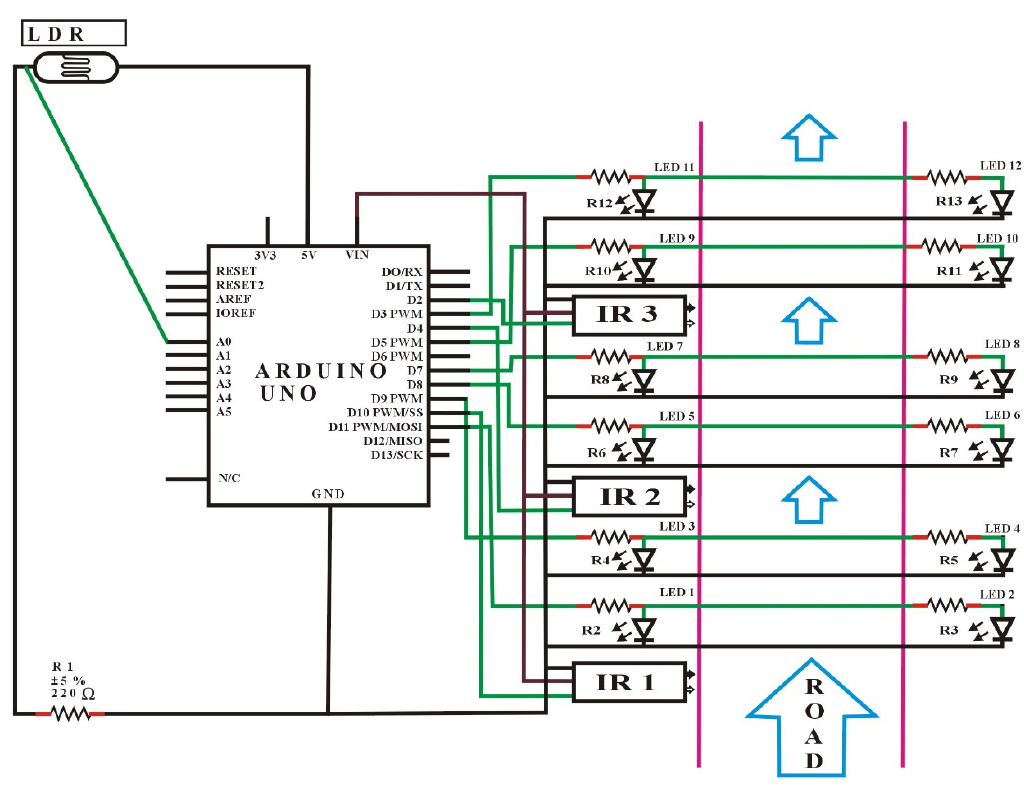
Figure 2. Circuit design of automation system based on night and objects’ detection.